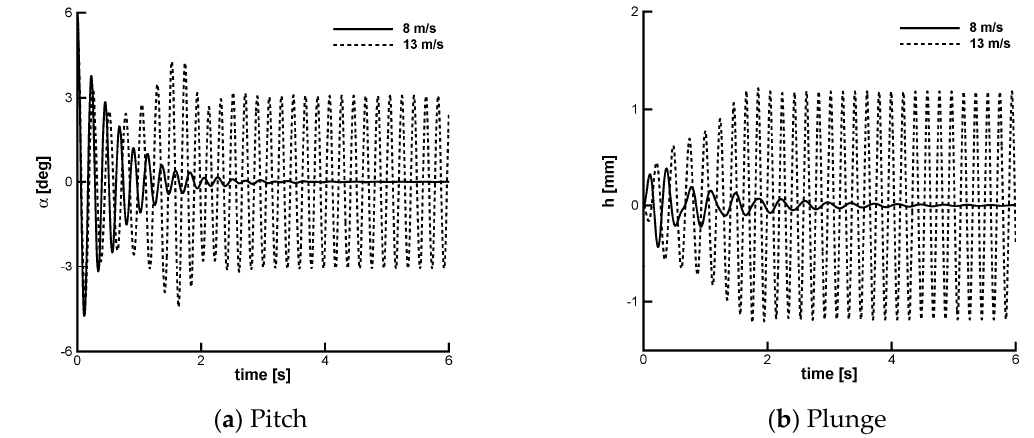
Figure 6. Time-domain response to an initial perturbation in angle of attack ( α 0 = 6 ◦ at two speeds below the flutter speed, predicted at U f = 15.28